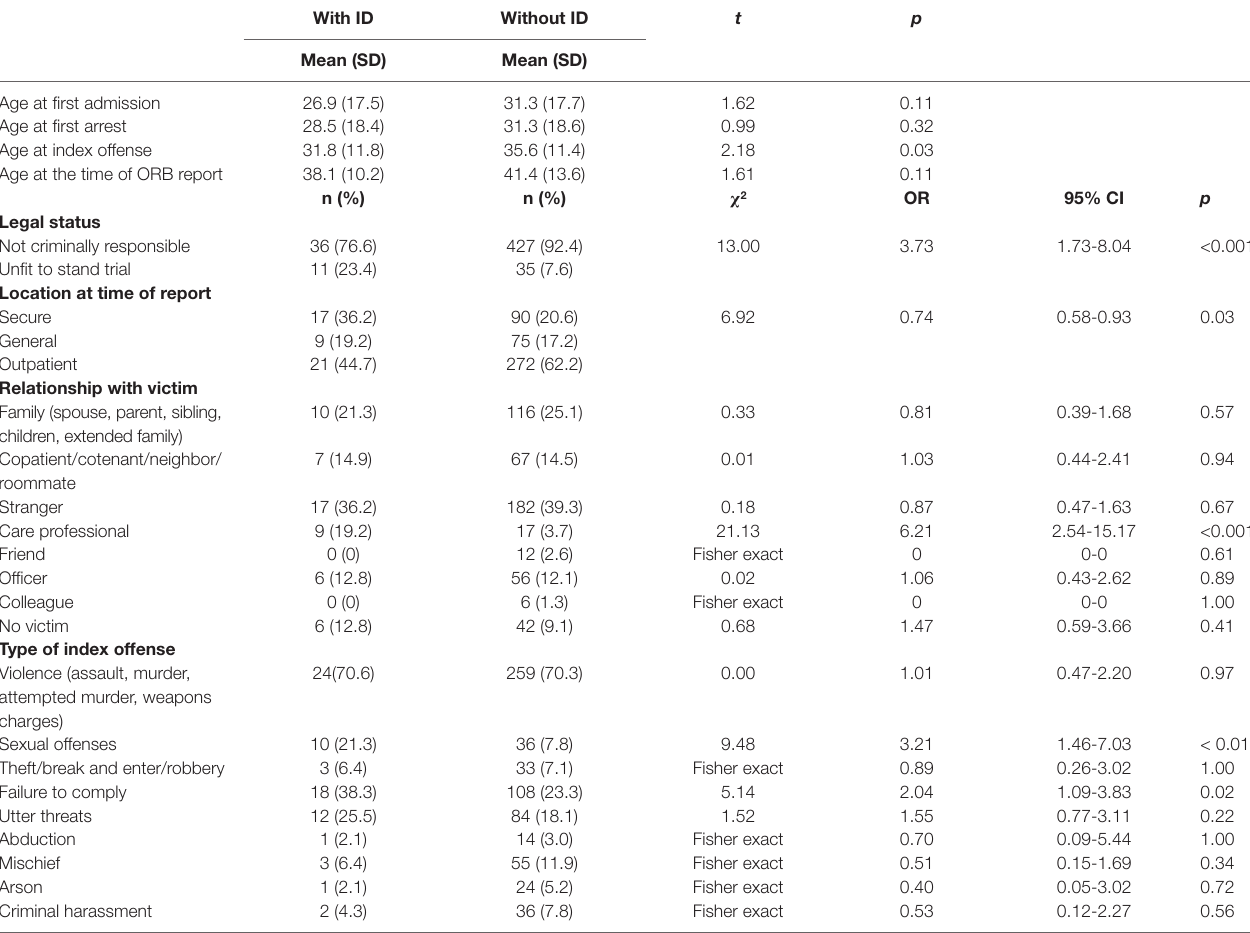
TABLE 3 | Forensic characteristics of patients with and without intellectual disability.